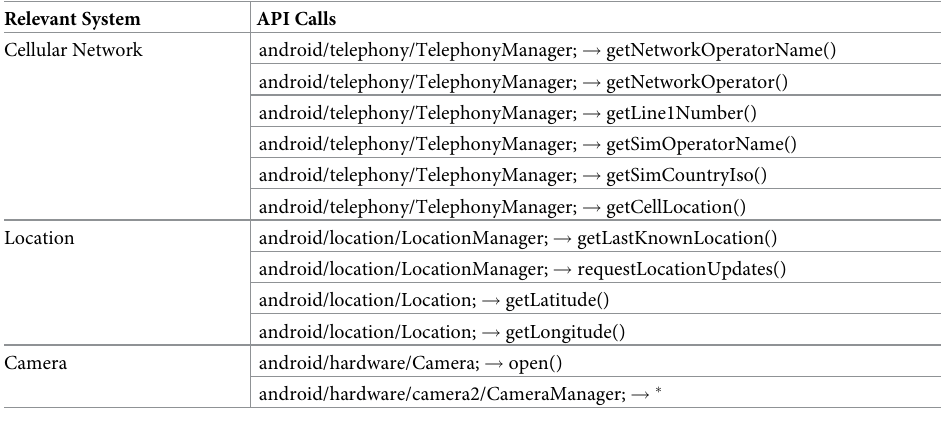
Table 4. Categorisation of sensitive API calls discovered in the